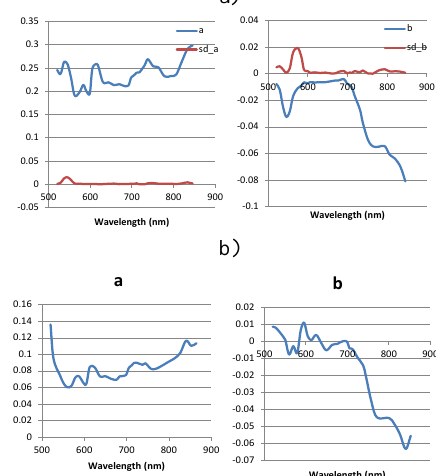
Figure 7. Empirical line parameters Refl=a*DN+b a) for flight f1 and b) for terrestrial pole position